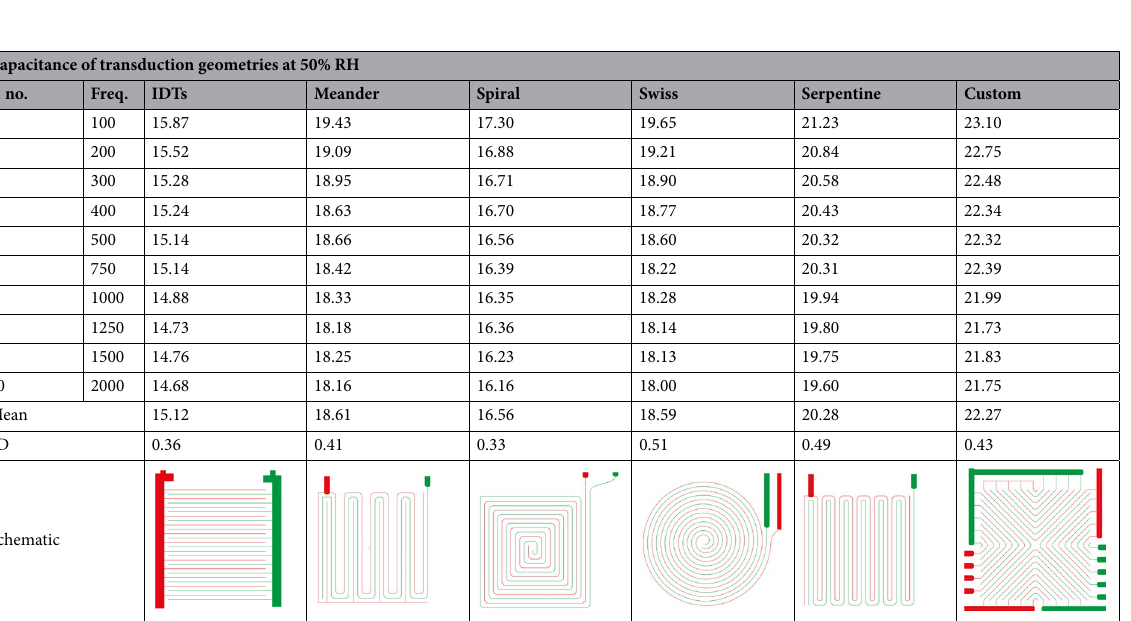
Figure 4. SEM images of cellulose decorated sensing layer. ( a ) Decorated cellulose before ultrasonication. ( b ) Decorated cellulose after ultrasonication.